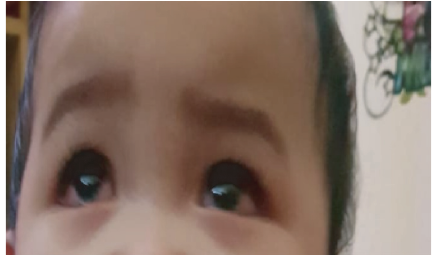
Figure 3: Bilateral nonpurulent conjunctivitis.